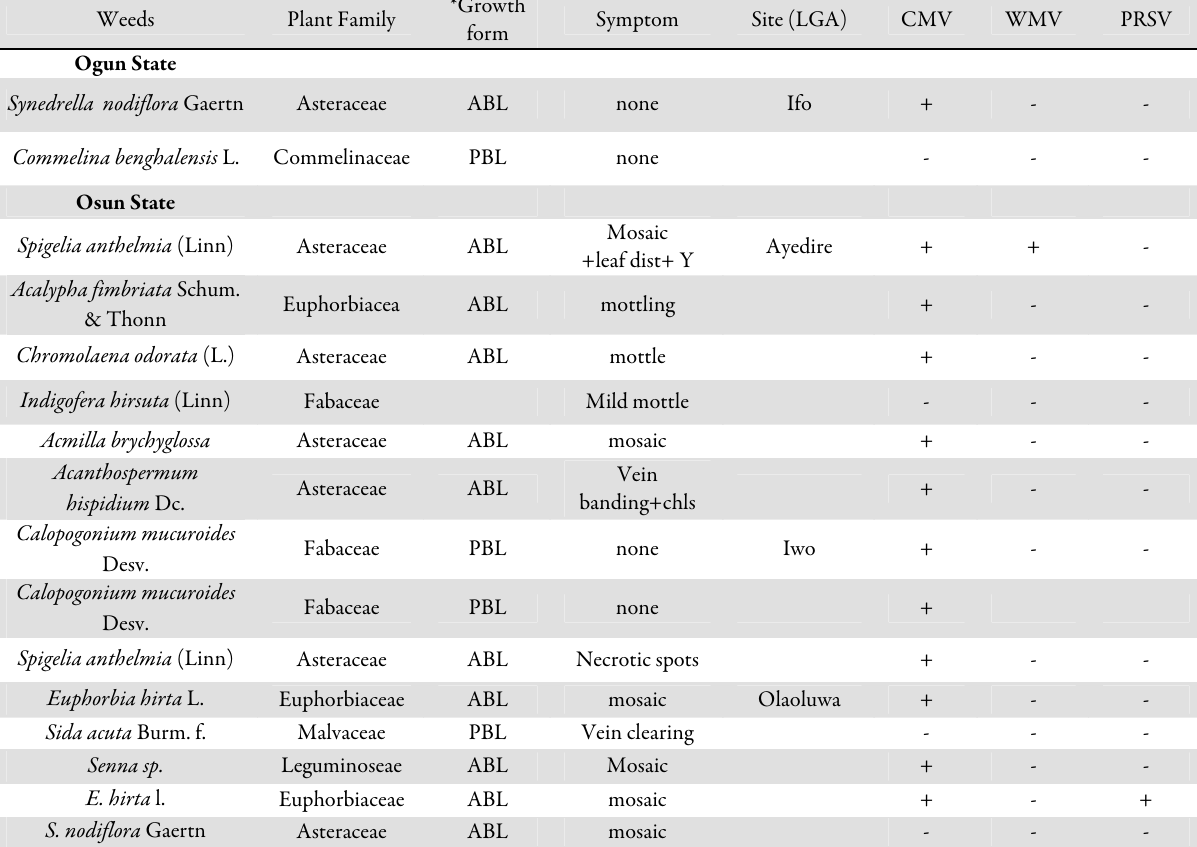
Tab. 6. Detection of viruses in weed leaf samples collected from fields grown with cucurbit crops in Ogun and Osun States in June